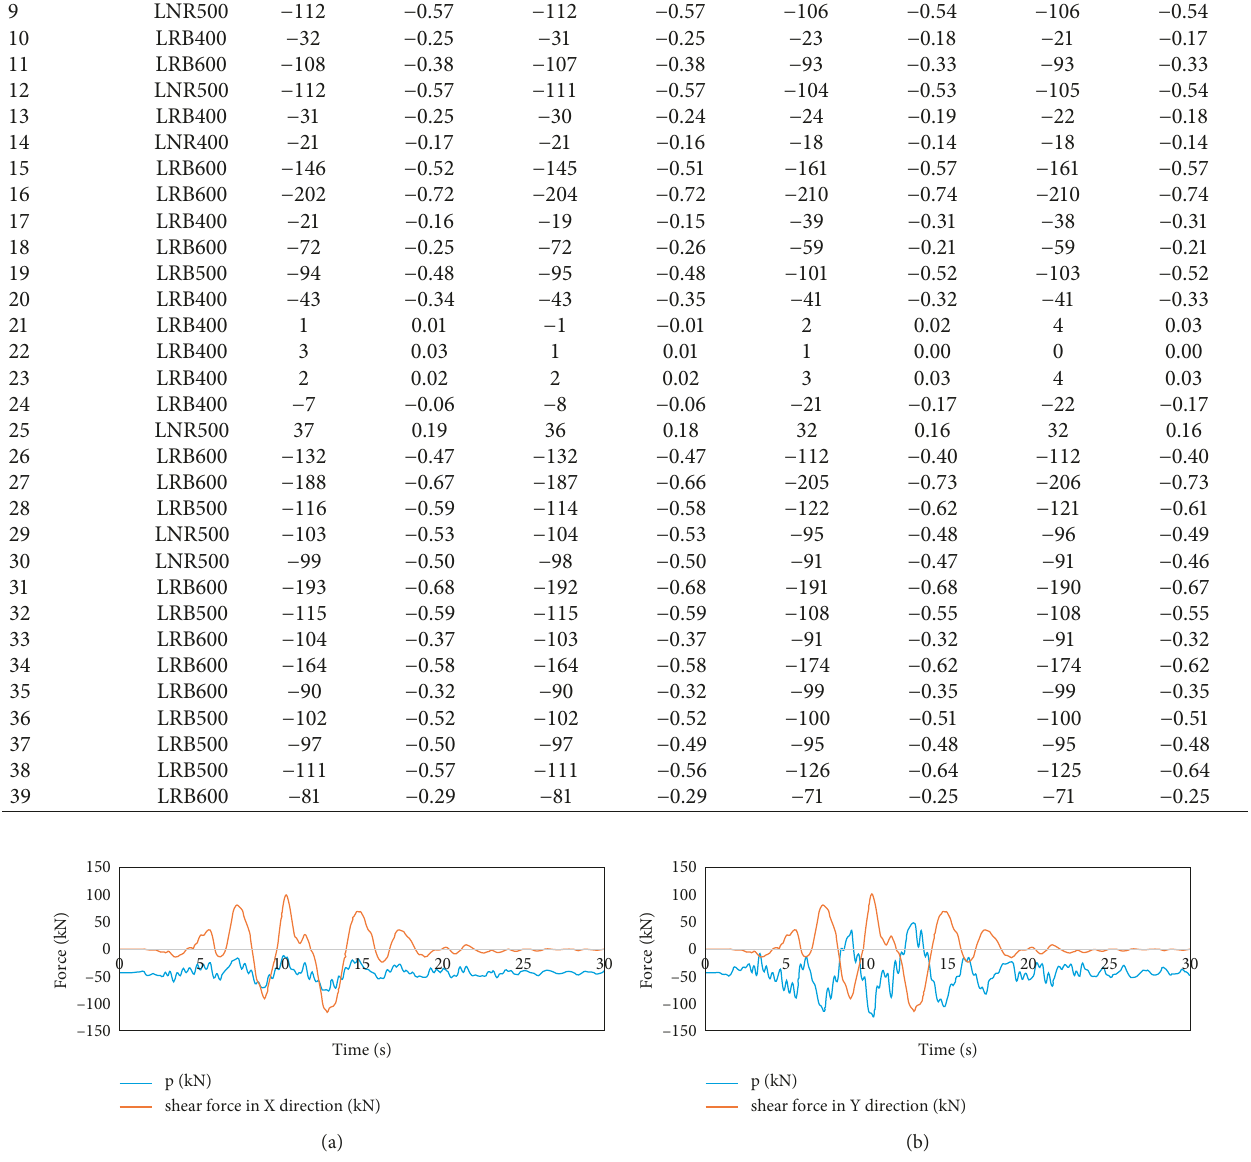
Figure 38: REN1 seismic waves under the bearing force time curve. (a) X-directional input. (b) Y-directional